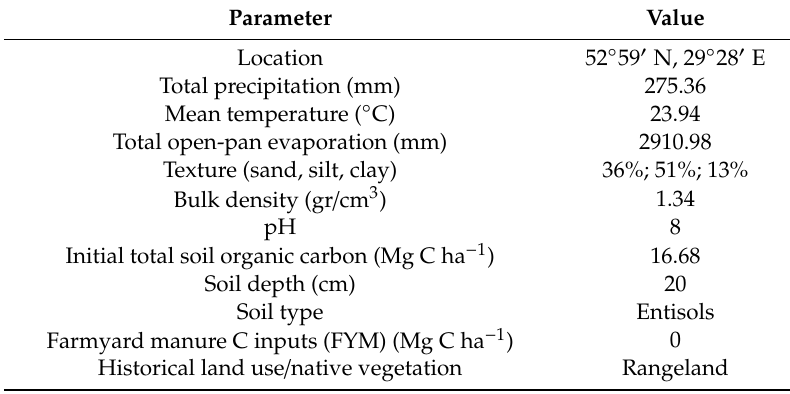
Table 1. Soil and vegetation characteristics and climatic parameters in BandBast rangelands.